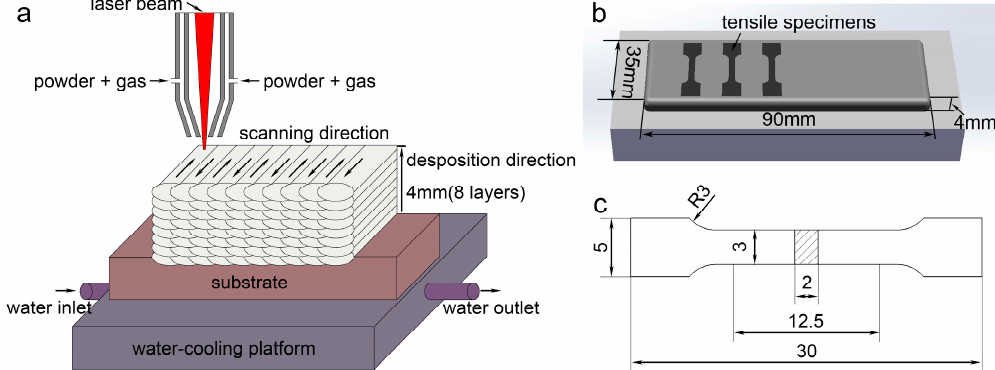
Figure 1. ( a ) Schematic of laser cladding process, ( b ) tensile specimens machined from the laser-cladded coating, and ( c ) geometry of the tensile specimens in mm scale.